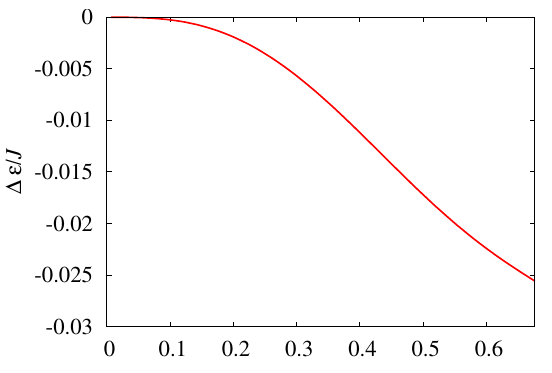
J'/J Figure 10: The energy difference between the bound triplons and two localized triplons as a function of their interaction ratio J (cid:48) / J